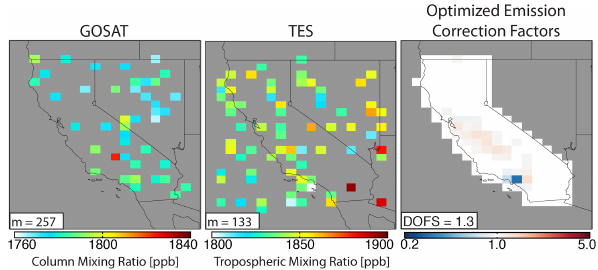
Figure 5. Mean methane mixing ratios measured by GOSAT (top left) and TES (top right) for the CalNex period of 1 May– 22 June 2010, a priori model concentrations (bottom left) at the times and locations of GOSAT, and optimized correction factors (bottom right) to the a priori EDGAR v4.2 methane emissions from the GOSAT inversion. Observations are plotted on the GEOS-Chem grid. The total number ( m ) of observations is inset. The TES data are vertical averages of tropospheric levels, while the GOSAT data are average column mixing ratios including the stratosphere, which explains the lower values. Model concentrations are sampled at the times and locations of GOSAT observations and have the GOSAT observation operator applied. DOFS from the GOSAT inversion is inset in the right panel. Gray grid squares in the right panel are ex- cluded from the